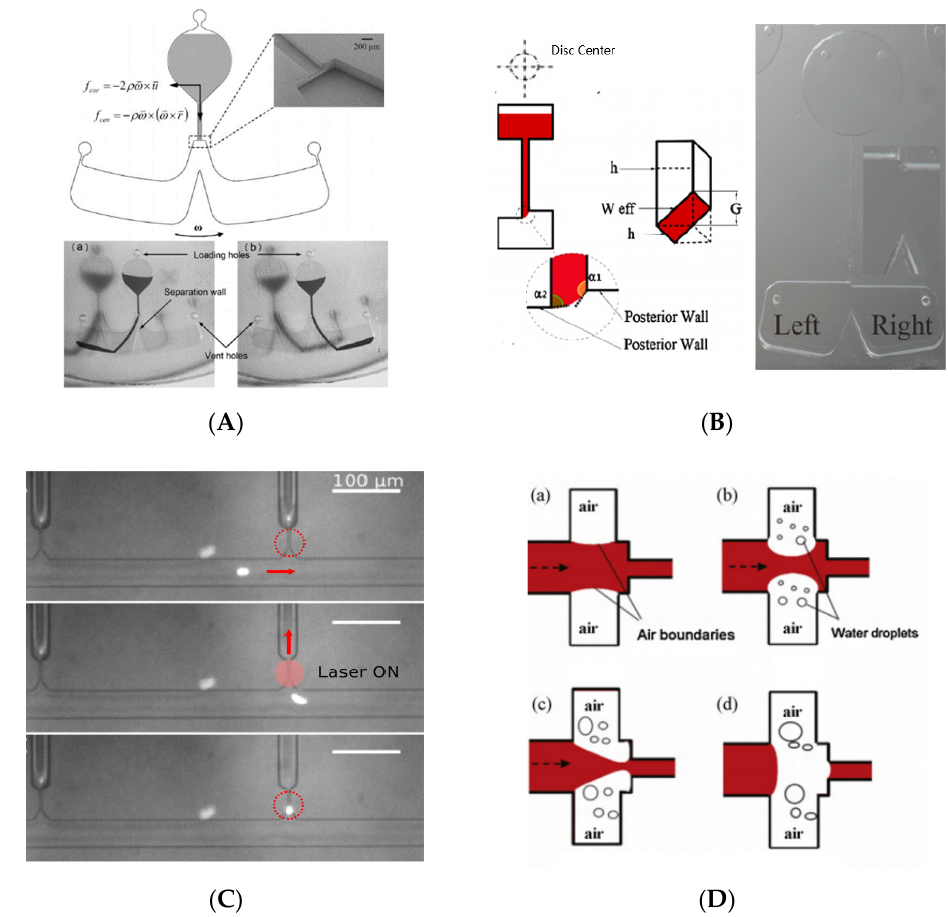
Figure 5. Different modes of valve actuation. ( A ) Centrifugal force drives CPCV by changing the direction of rotation to allow the liquid to enter different chambers. Reprinted with permission from [133]. ( B ) Asymmetric structure, centrifugal force driven, changing the speed of liquid into different chambers. Reprinted with permission from [134]. ( C ) The laser drive is used to capture particles. Reprinted with permission from [135]. Copyright 2017 American Institute of Physics. ( D ) An exam- ple using thermally driven CPCV. Reprinted with permission from [136].